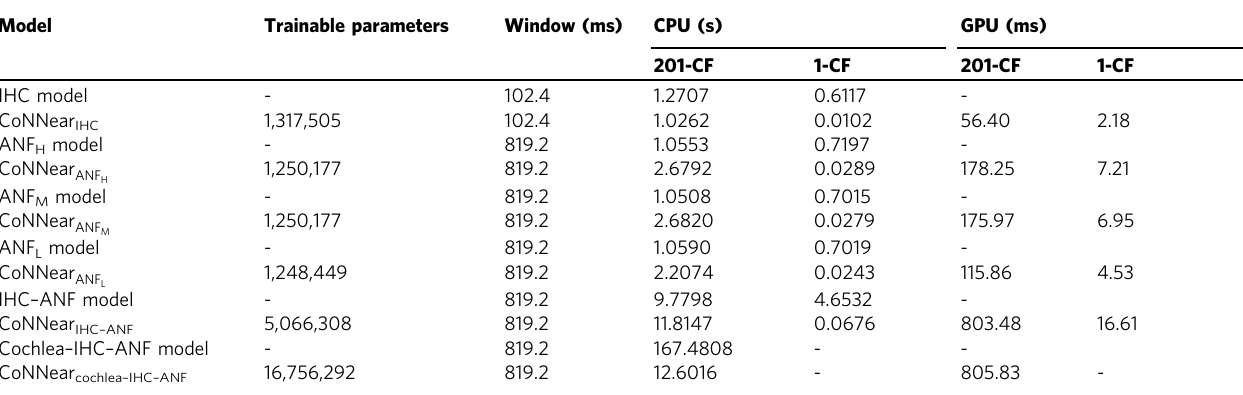
Table 2 CoNNear execution